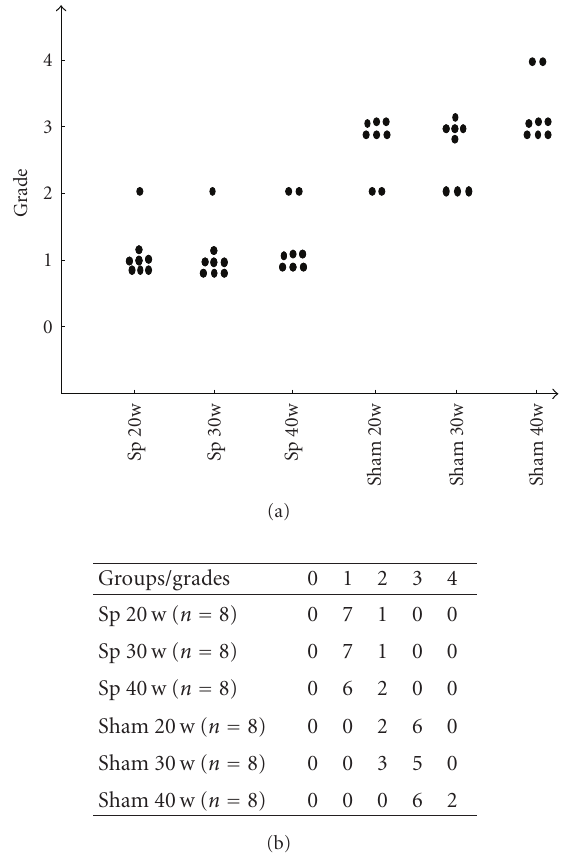
Figure 1: Chronic inflammatory changes of splenectomized (Sp) and sham aly/aly mice at the ages of 20, 30, and 40 weeks old, respectively. The pancreas was histopathologically examined (refer to Figure 2). Grading of inflammatory lesions of the pancreas: 0, no visible change; (1), focal accumulation of lymphoid cells; (2), focal accumulation of lymphoid cells with evidence of tissue damage; (3), extensive lymphoid cell infiltration with tissue damage ( < 30%); (4), replacement by adipose tissue ( >